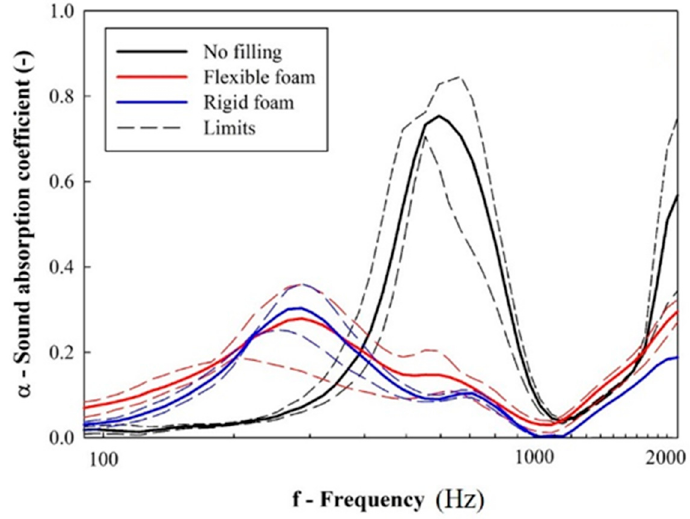
Figure 10. Results from sound absorption coefficient (solid and dashed lines represent, respectively, the average and maximum/minimum values).